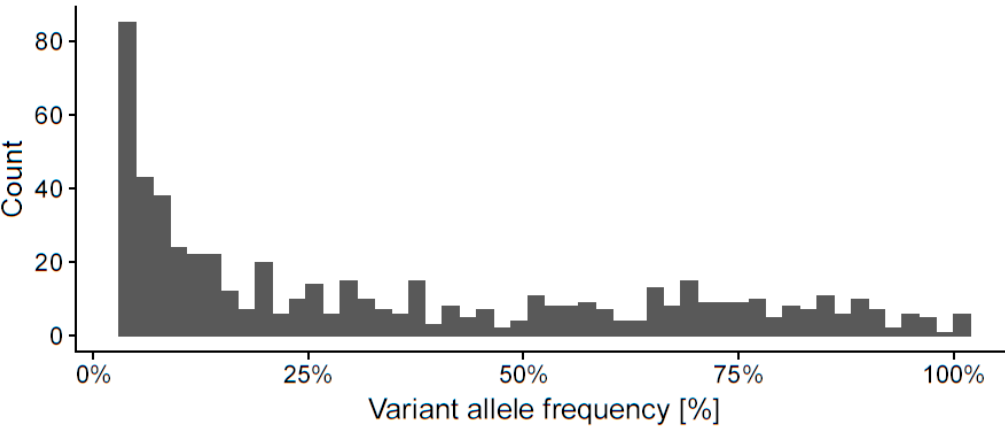
Figure A2. Histogram of variant allele frequency of the somatic mitochondrial DNA variants of 381 primary breast tumor cases. Histogram of the variant allele frequency (horizontal) of the somatic mitochondrial DNA variants detected in the 381 primary breast tumor cases.